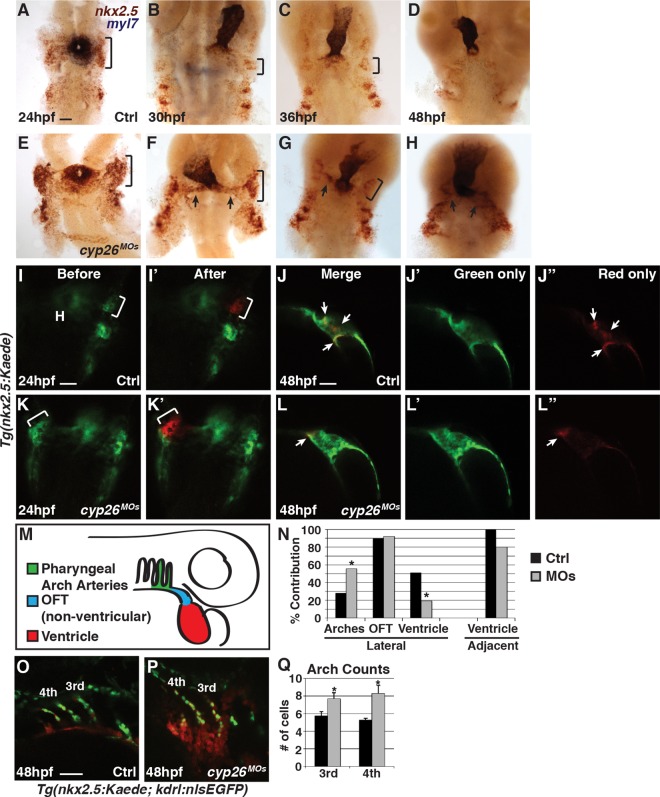
SHF progenitors do not add to the heart tube in Cyp26-deficient embryos.(A–H) ISH of control and Cyp26-deficient Tg(nkx2.5:ZsYellow) embryos at 24 (A,E), 30 (B,F), 36 (C,G), and 48 (D,H) hpf. Nkx2.5:zsyellow (red) and myl7 (purple). (A–C,E–G) Brackets indicate nkx2.5:ZsYellow+ cells in the first nkx2.5+ pharyngeal arch. (F,G) Arrows indicate accumulation of nkx2.5+ cells adjacent to the arterial pole of the heart. (I,I’,K,K’) Tg(nkx2.5:Kaede) before and after photoconversion of the anterior lateral population of nkx2.5+ cells (bracket) in control and Cyp26-deficient embryos at 24 hpf. (J–J”,L–L”) Position of photoconverted cells (red, arrows) relative to the heart tube (green) in control and Cyp26-deficient embryos at 48 hpf. Images in I–J” and K–L”, respectively, are of the same control and Cyp26-deficient embryos. (M) Schematic depicting the three regions where photoconverted nkx2.5:Kaede+ cells contributed at 48 hpf. (N) Graph depicting percentage of contribution to the third and fourth PAAs, non-ventricular OFT, and ventricular cardiomyocytes (control-lateral n = 39, control-adjacent n = 8, Cyp26-deficient–lateral n = 52, Cyp26-deficient–adjacent n = 5). (O,P) Confocal images of arch arteries in Tg(nkx2.5:Kaede; kdrl:nlsEGFP) control and Cyp26-deficient embryos. (Q) Graph depicting quantification of the endothelial cell number in the third and fourth PAAs in control (n = 18) and Cyp26-deficient (n = 24) embryos. Ventral view, anterior up (A–H); dorsal view, anterior up (I,I’,K,K’); lateral view, anterior up (J,J’,J”,L,L’,L”); lateral view, anterior right (O,P). n > 20 per group for (A–H). Asterisk denote p < 0.05 by Chi Squared test. H, heart. Scale bar: 50 μm.